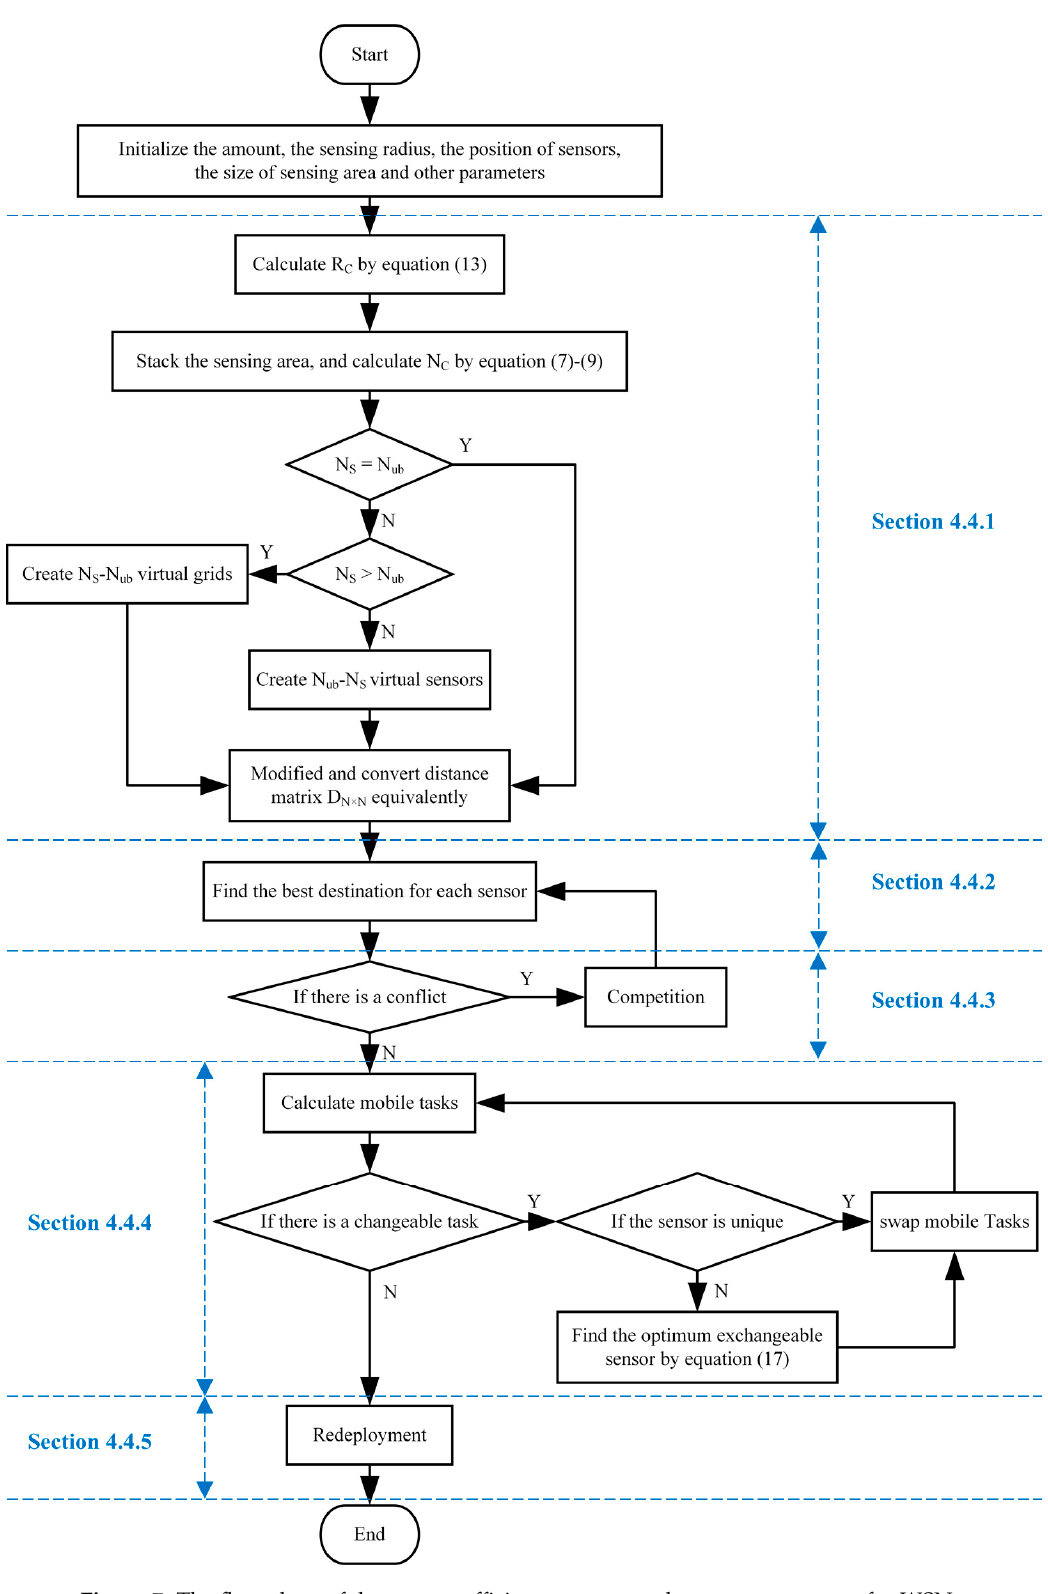
ffi cient coverage enhancement strategy for Figure 7. The flow chart of the energy ‐ efficient coverage enhancement strategy for WSNs. Figure 7. The flow chart of the energy-e